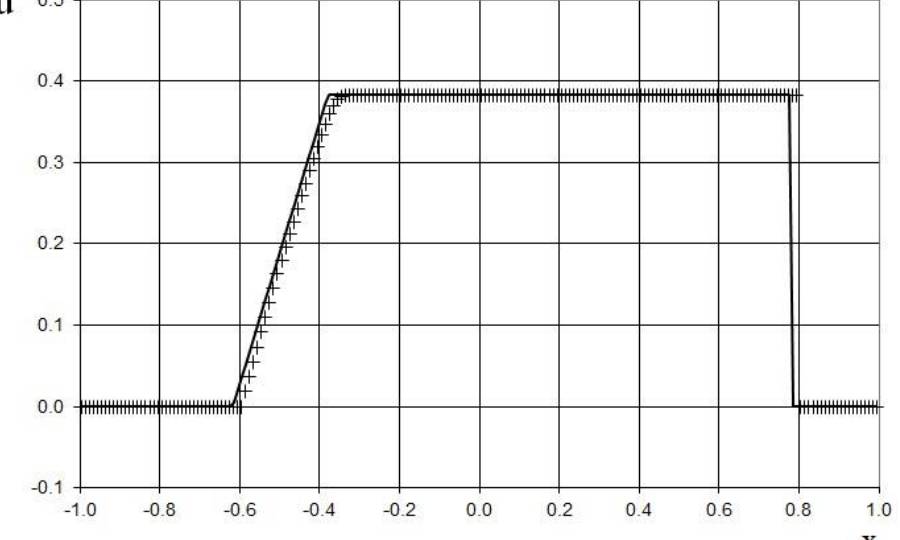
Figure 5. Density plot for the shock-tube problem (46) for the adiabatic gas dynamics equations: the exact solution (line), and the present method (cross).